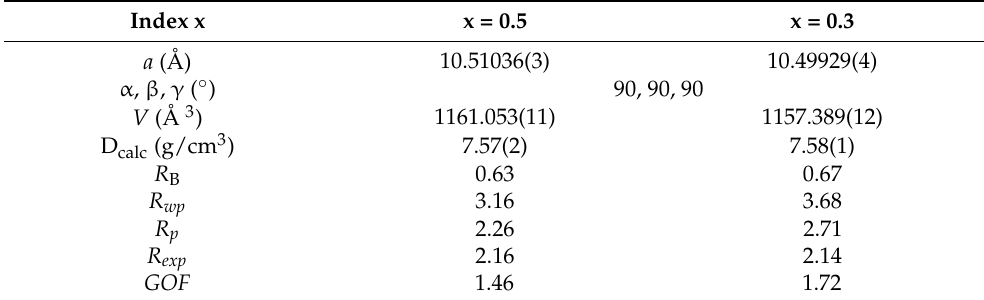
Figure 2. Experimental (blue circles), calculated (solid red line) and difference (gray line) XRD patterns of Bi 2 Mg 0.3 Fe 0.7 Ta 2 O 9.5- Δ . Table 1. Parameters of atoms in the Bi 2 Mg x Fe 1-x Ta 2 O 9.5- Δ (x = 0.5;0.3). x = 0.5